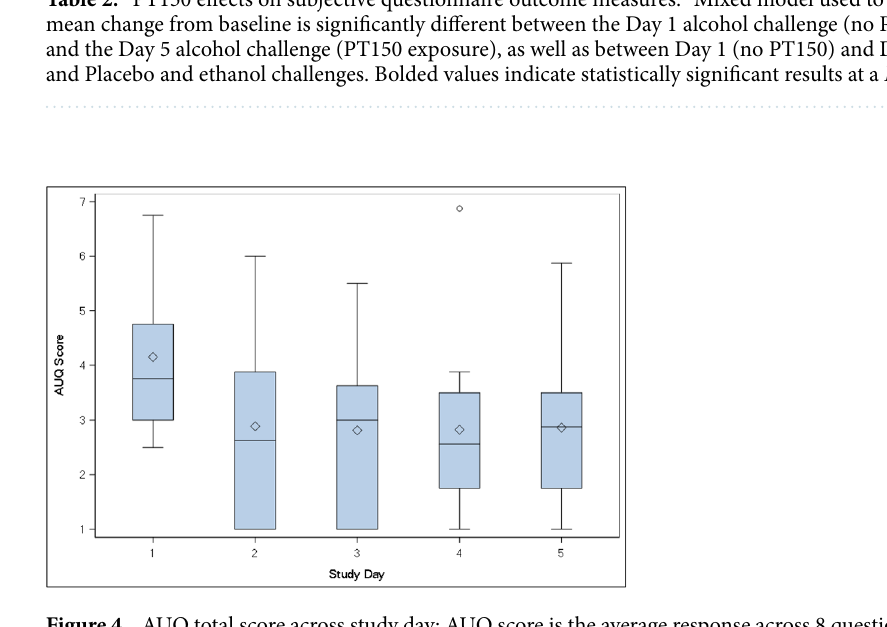
contrast, a prior thorough QT (TQT) study in which mifepristone 1800 mg was administered for 14 days showed a placebo-corrected, change-from-baseline QTc of 7.4 ms (90% CI 2.8–12.0) 32 . As noted above, human studies with PT150 alone revealed no significant group differences across any of the group ECG parameters. Our study is reassuring that PT150 did not cause clinically significant ECG changes at PT150 initiation or in response to increase in blood levels. Thus, while ECGs should be obtained and closely monitored as with any glucocorticoid antagonist, PT150 appears to be a safe compound when used with alcohol. There was no evidence of a statistically significant difference in blood alcohol concentration summary meas- ures with PT150 and ethanol compared to ethanol ingestion alone, including observed C max , T max , and AUC at 2-h. These results indicate that the eBAC do not change in the presence of PT150 at steady state, providing further